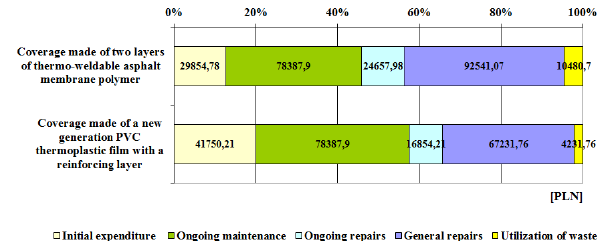
Figure 3: Percentage of individual components in the life cycle costs of roof covering for two